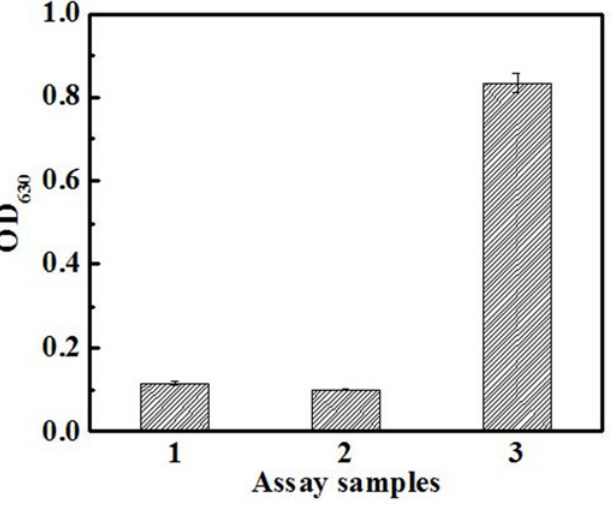
Fig 2. Activity determination of CDA. 1- reaction reagent without CDA and cytidine; 2- reaction reagent with CDA and without cytidine; 3- reaction reagent with CDA and cytidine. The concentration of cytidine is 1 mmol/L. The experiments were performed in